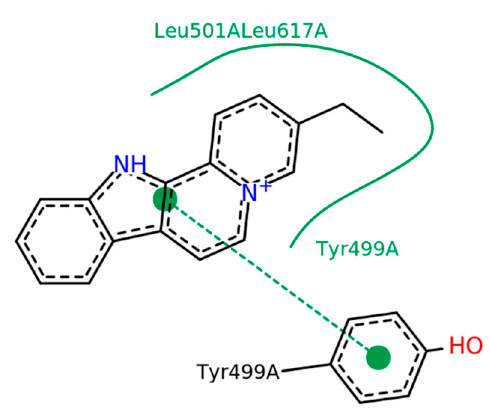
Figure 4. Intermolecular interactions between flavopereirine and OpB. In green outline, Van der Waals interactions; in dotted green line, π -stacking interactions. Image generated using PoseView (Version 1.1, BioSolveIT GmbH, St. Augustin, Germany) [25].